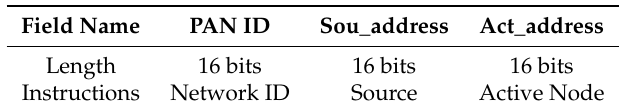
Table 2. Active frame.